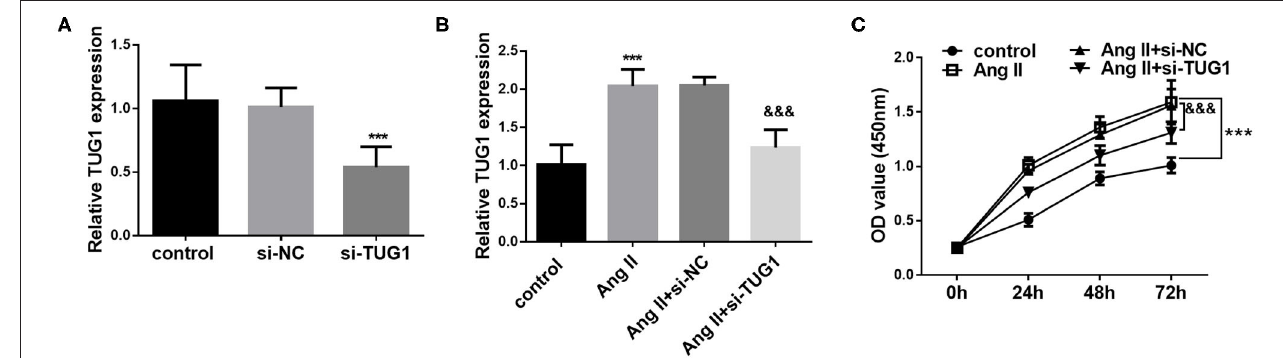
FIGURE 2 | Knockdown of TUG1 inhibited AngII-induced CF proliferation. (A) si-TUG1 transfection significantly decreased the level of TUG1 in CFs. (B) AngII treatment significantly upregulated the level of TUG1, which was reversed by TUG1 knockdown. (C) AngII promoted CF proliferation, but knockdown of TUG1 reversed the promotion effect of AngII on CF proliferation (*** p < 0.001, compared with the control group; &&& p < 0.001, compared with the AngII group).